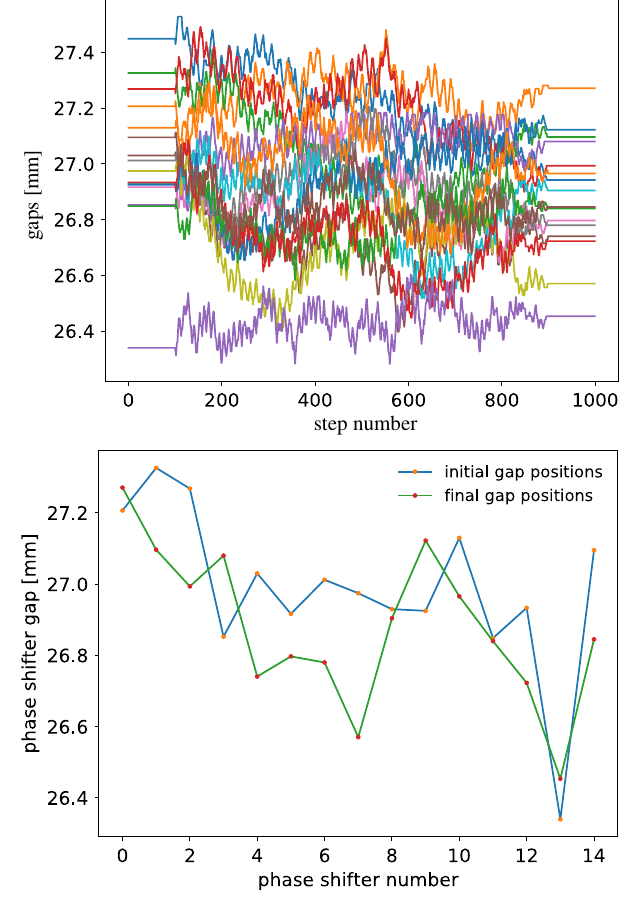
FIG. 3. Tuning 15 phase shifter gaps to maximize average bunch energy. Although the energy signal is extremely noisy and exhibits large excursions due to other accelerator setting drifts and changes, to which the algorithm is